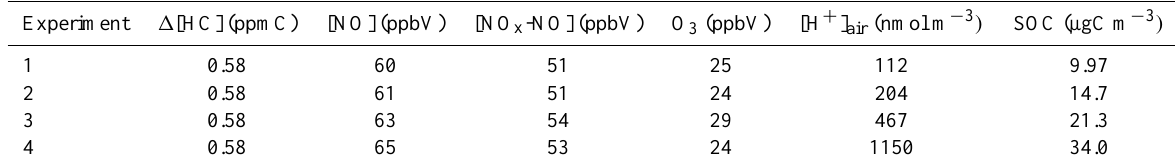
Table 1. Steady state concentrations of gas-phase species, aerosol acidity, and secondary organic carbon (SOC) for β -caryophyllene/NO x irradiation experiments, reproduced from Offenberg et al.